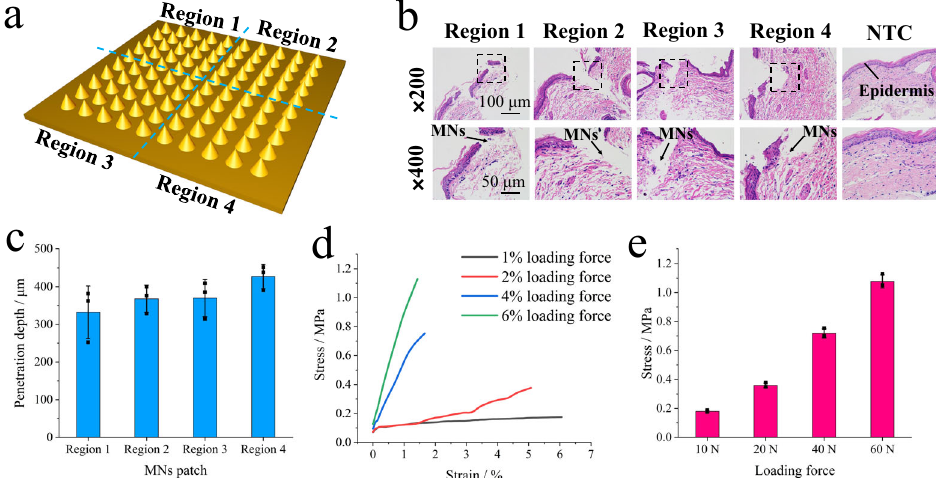
Fig. 4 Mechanical properties of the microneedles. a The schematic for four regions of the MNs, each group of 25 needles. b Histological analysis of piglet skin after MNs administration, stained with HE, the black arrow referring to the direction of microneedles insertion, the black short dash box referring to the region of magni fi cation photograph (×400). c The depth of MNs penetration into piglet skin, collected from four regions, data presented as mean values ± SD, n = 3 independent experiments. d The compression tests for the microneedle arrays with different loading forces, using 1 kN force sensor. e The evaluation of mechanical strength for the microneedle arrays, the maximum stress data collected from ( d ), data presented as mean values ± SD, n = 3 independent